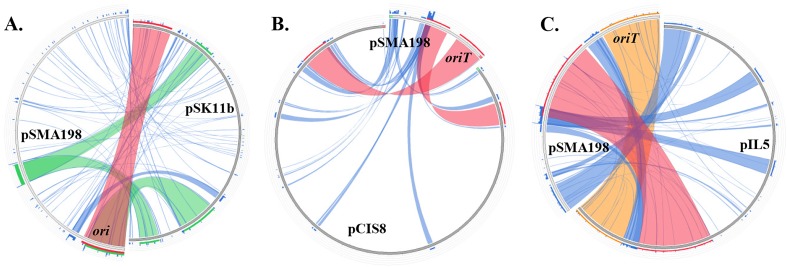
Sequence alignment of pSMA198 against pSK11b (A), pCIS8 (B) and pIL5 (C) represented in a circular fashion using Circoletto [30].Local alignments produced by BLAST are presented using ribbons whose color corresponds to four quartiles of the alignment’s bitscore (red: top 25%, orange: second 25%, green: third 25% and blue: worst 25%). The positions of pSMA198 ori or oriT were added in order to aid orientation.